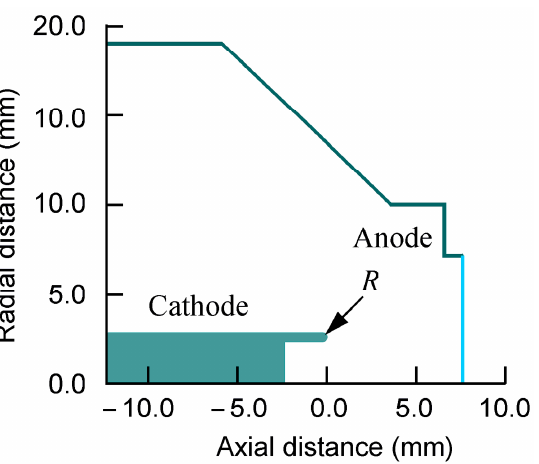
Figure 2. Real configuration of the coaxial air diode “tubular edge cathode–flat anode” from the experiments [30,31,36].